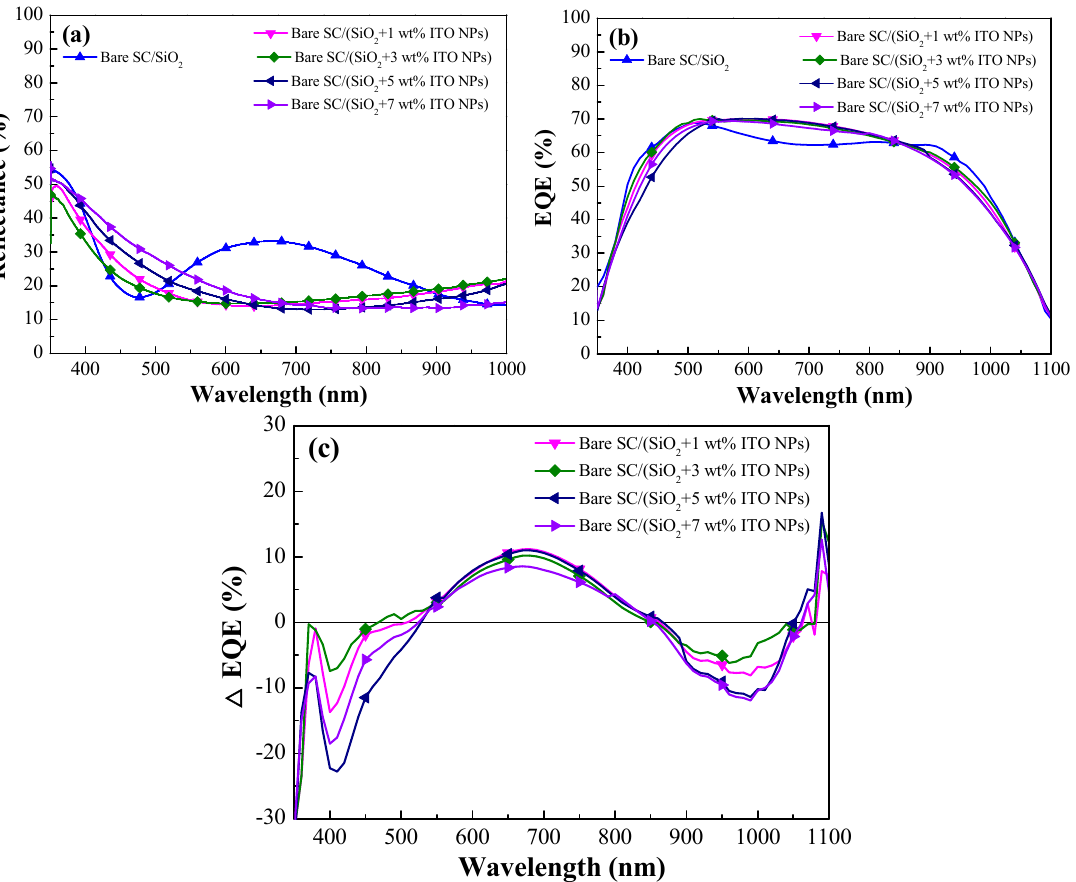
Figure 9. ( a ) Optical reflectance spectra of a cell coated with a layer of SiO 2 and cell coated with a layer of SiO 2 containing various concentrations of ITO-NPs; ( b ) external quantum e ffi ciency (EQE) responses of the same cells; ( c ) EQE enhancements ( ∆ EQE ) of the same cells, which was compared with the cell with a layer of SiO 2